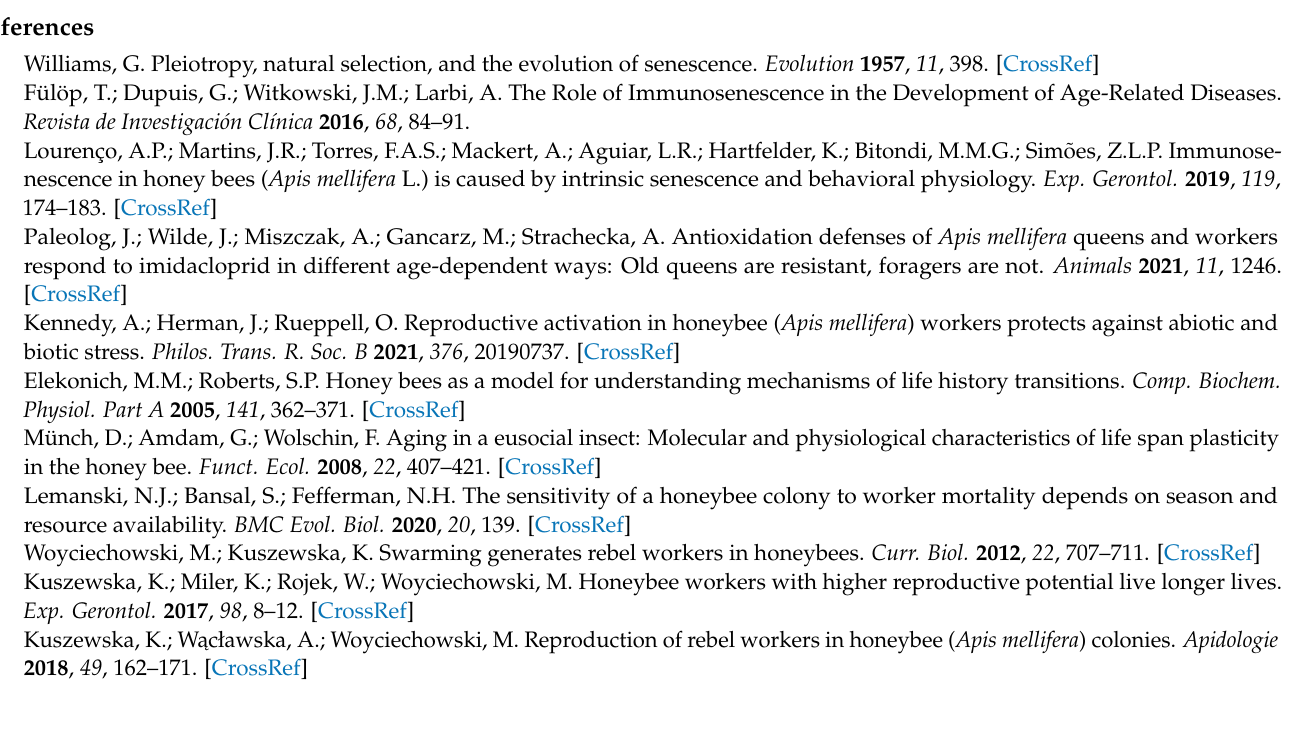
Table S2: Auxiliary statistics helpful for interpretation of data in Figure 4A,B; differences between RW and